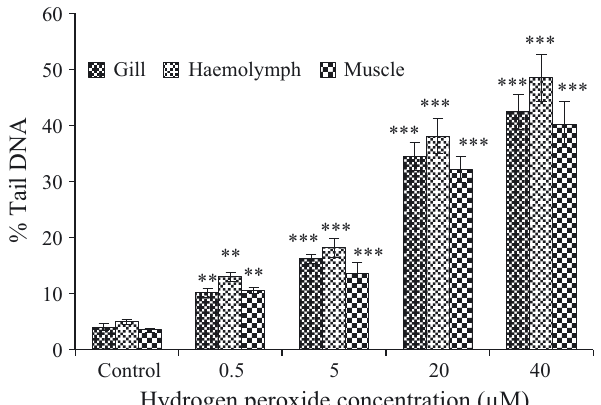
Fig. 1. Percent DNA damage in different cells of Litopenaeus vannamei juveniles exposed to different concentrations of hydrogen peroxide. Data are mean ± SD (n = 100 comets). **p < 0.01, ***p < 0.001